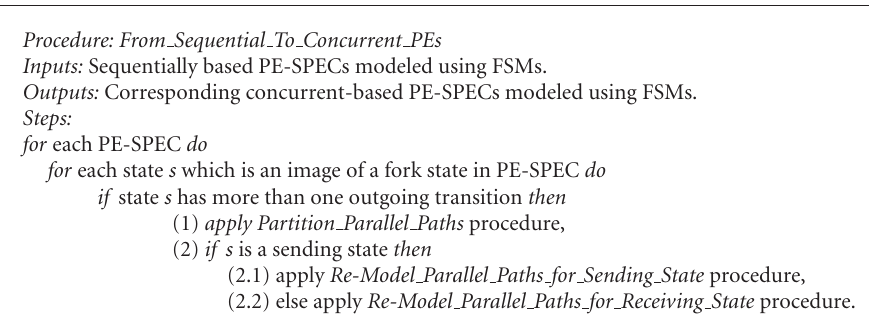
Algorithm 2: Procedure for obtaining concurrent-based PE-SPECs from sequentially based PE-SPECs.